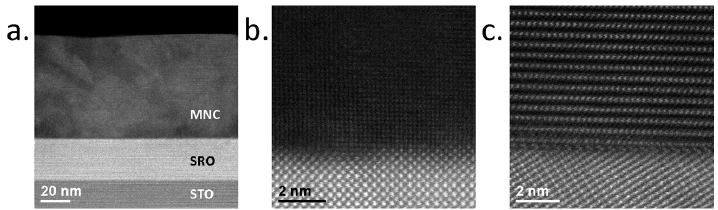
Figure 8. Cross-sectioned HAADF-STEM images of Li 1.2 Mn 0.55 Ni 0.15 Co 0.1 O 2 (MNC) films grown at 600 °C. ( a ) The general view; and ( b ) the MNC/SRO interface for STO(100) at the [001] STO zone axis orientation, with the film oriented to [323] m ; ( c ) The MNC/SRO interface for STO(111) in [110] STO zone axis orientation, with the film is oriented to [010] m .